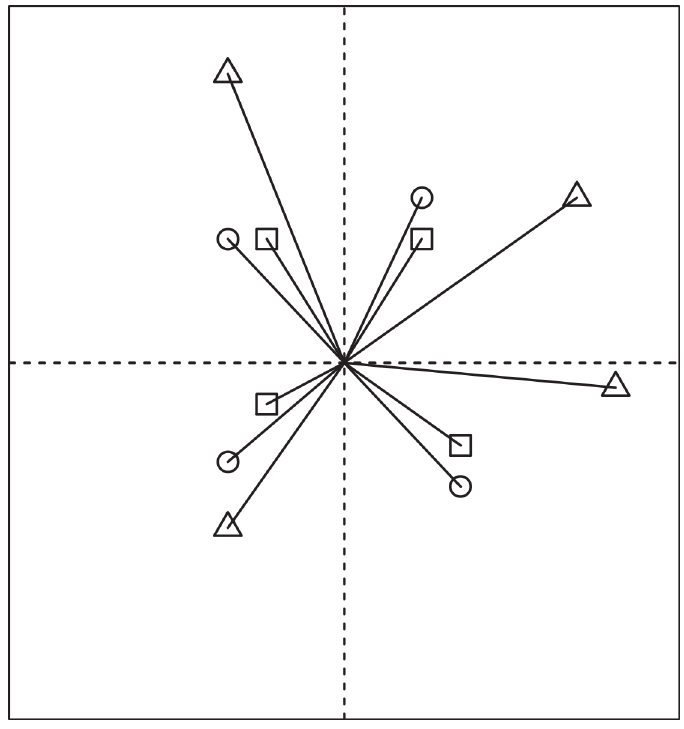
Fig 1. Schematic representation of a PCQM sample point with trees represented as circles, squares or triangles. In this example squares are always the nearest to the sample point and represent trees measured for PCQM, followed by circles for PCQM2 and triangles for